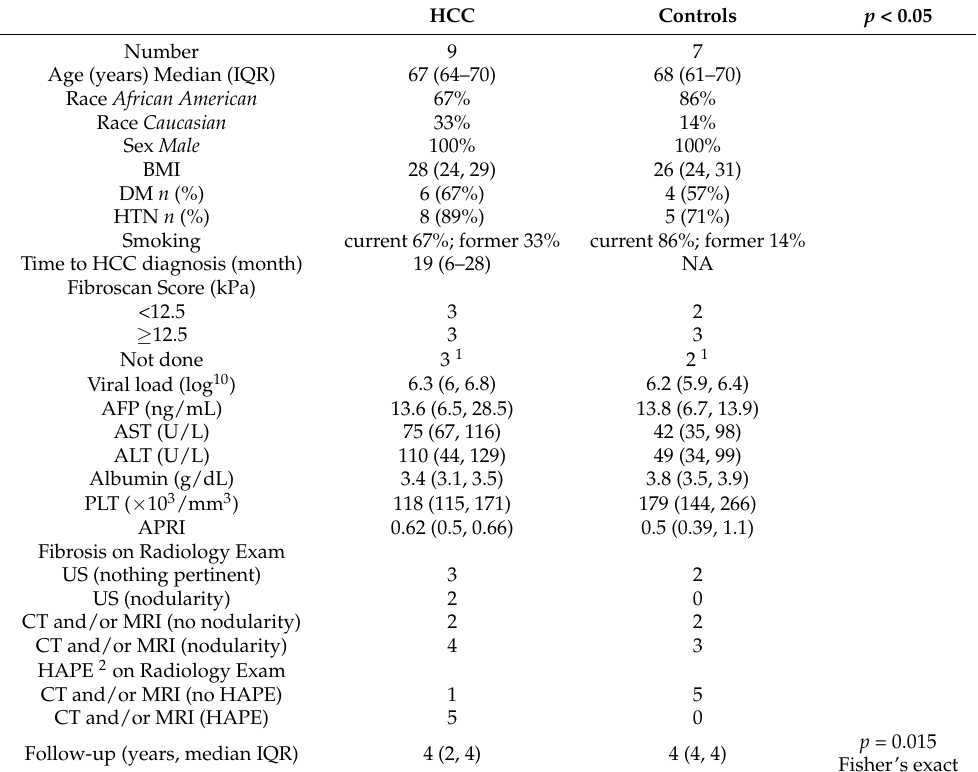
Table 1. Patient